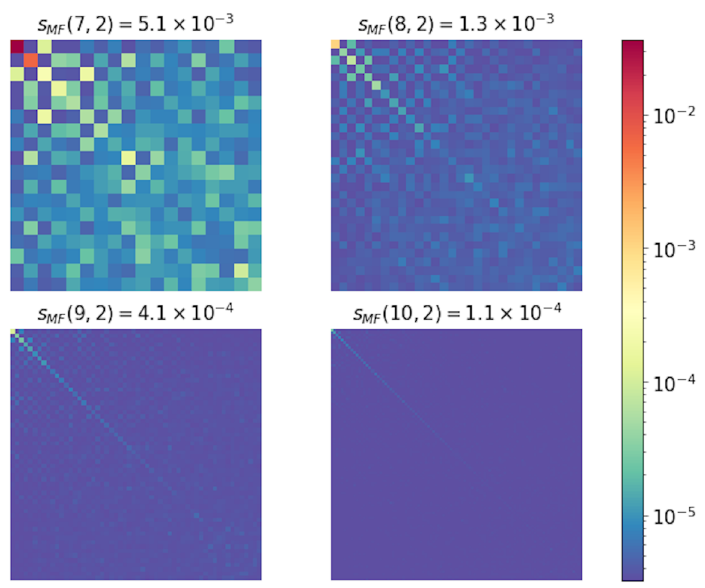
Figure 26 . The ECH matrices of the mixed-field Ising model of length N = 7 , 8 , 9 , 10 at the maximally chaotic point h = 0 . 5 , g = − 1 . 05 , with k = 2 -local operators taken as simple.